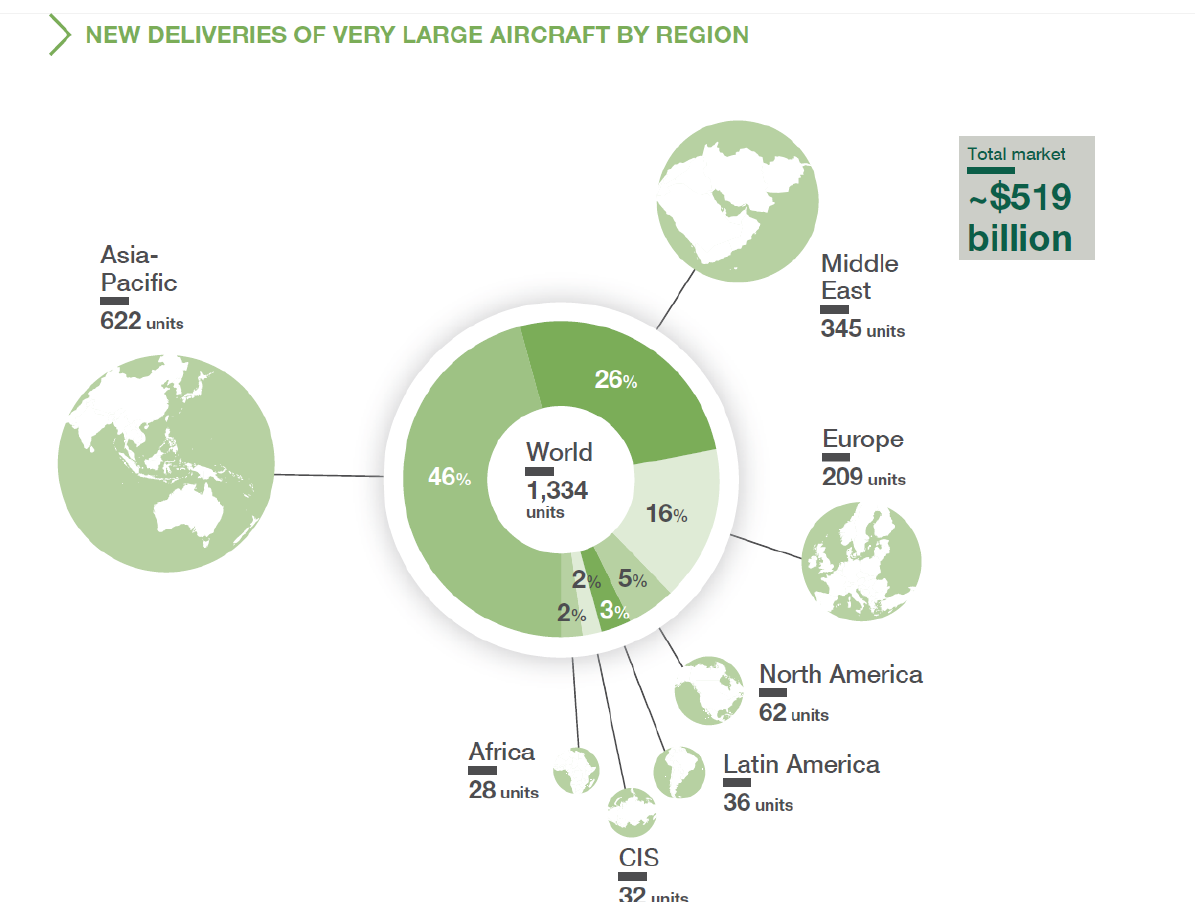
Figure 2. New Deliveries of VLA by Region [source: OAG,